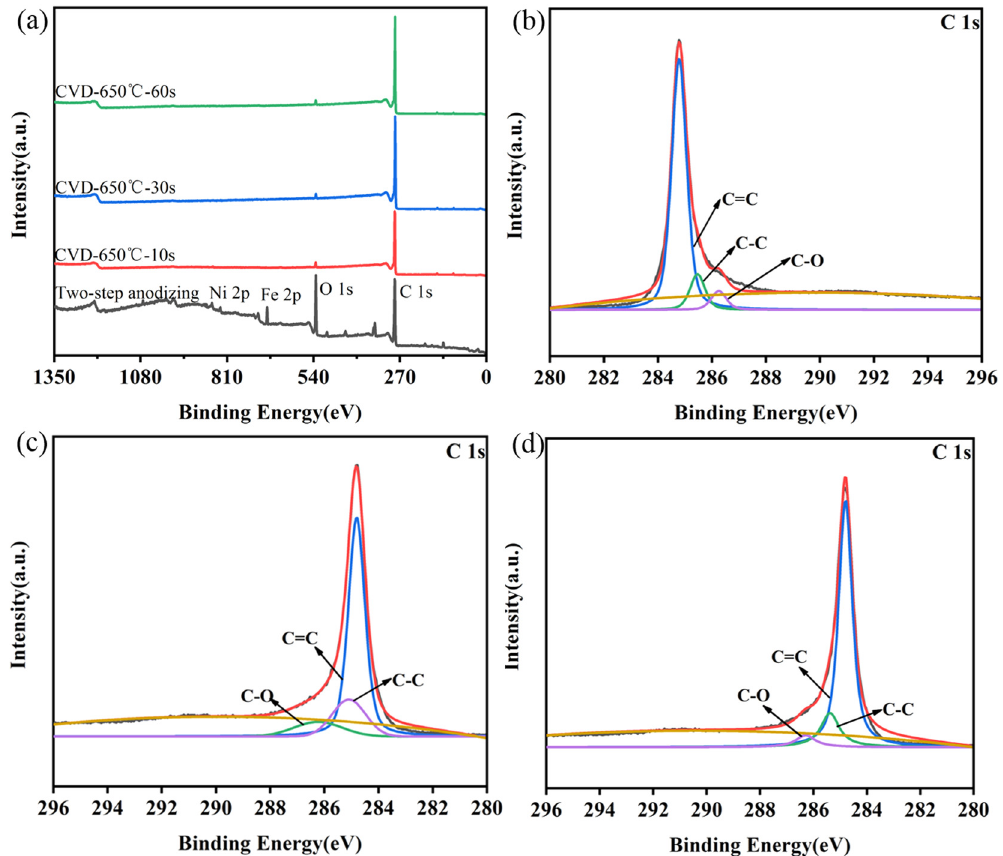
Figure 5: XPS spectra and C 1s spectra at di ff erent growth time on the surface of CNTs alloy grown in situ by two - step anodic oxidation. ( a ) Full spectrum; ( b ) 10 s; ( c ) 30 s; ( d ) 60